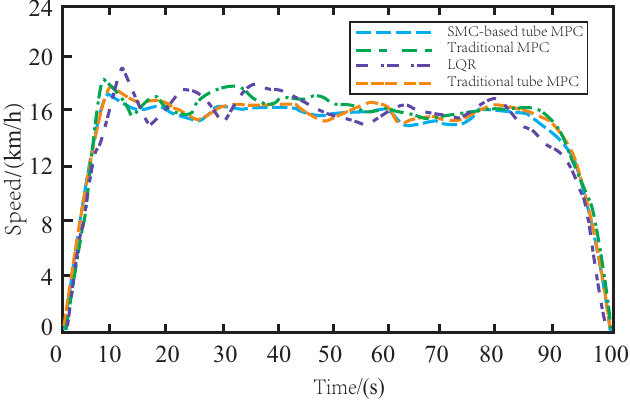
Figure 12. The variation of speed on the icy road. Figure 13a–c illustrate the lateral and longitudinal errors of the four control methods on three different road surfaces, namely, muddy, snowy, and icy roads. The LQR and MPC methods exhibit large deviations in both the horizontal and vertical directions, indicating poor robustness. However, the addition of an auxiliary control law to overcome external disturbances can significantly improve the controller’s performance. The traditional tube MPC method displays high tracking accuracy with small horizontal and vertical errors.